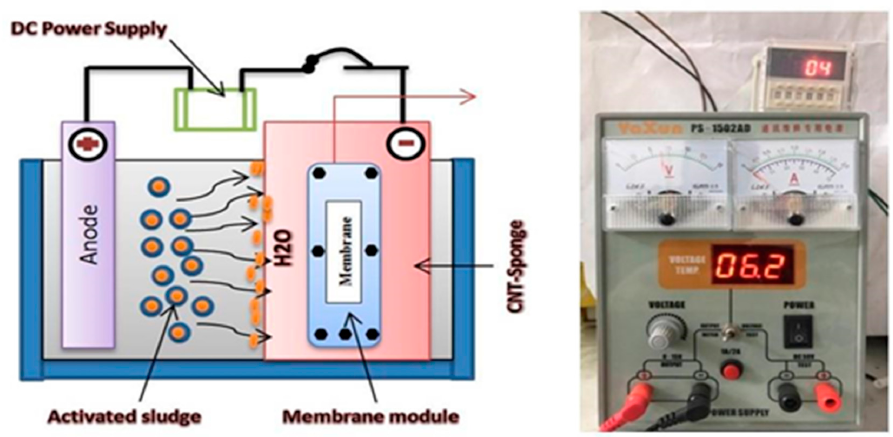
Figure 3. ( Left ) Schematic diagram of carbon nanotubes (CNT)-sponge configuration, ( Right ) DC power supply and timer model.